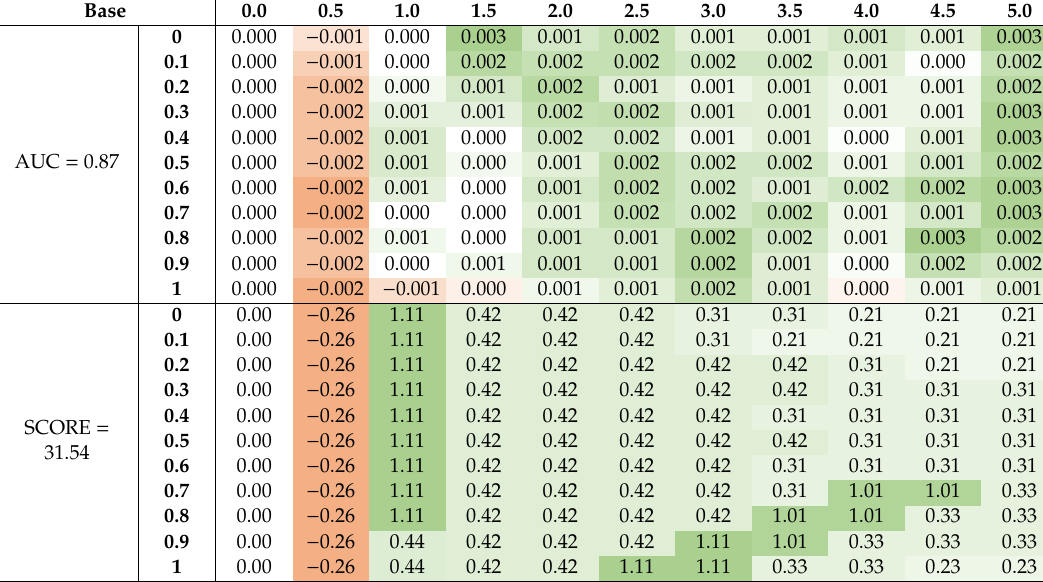
Table 8. Improvement of AUC and Score for Ventricular Tachycardia on validation sample in terms of the α -parameter and p